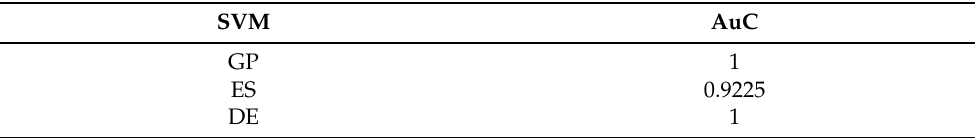
Table 1. AuC of SVM spectrum sensing method based on GP, ES and DE.